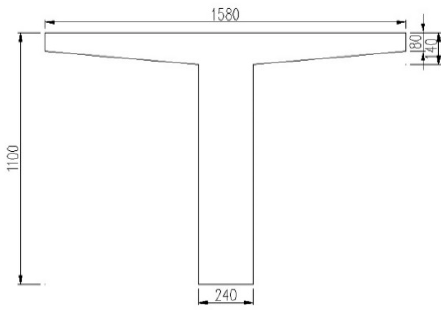
Figure 16. Side elevation of the bridge (mm).